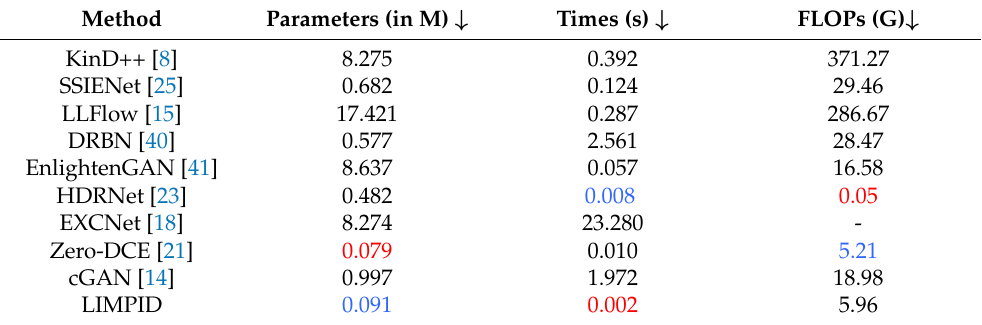
Table 2. Three objective metrics indicate the complexity of the model: parameters (in M), running time (in seconds), and FLOPs (in G), where FLOPS is the result of an input size of 256 × 256 × 3. ‘-’ indicates the result is not available. Red and blue denote the best and second-best results,